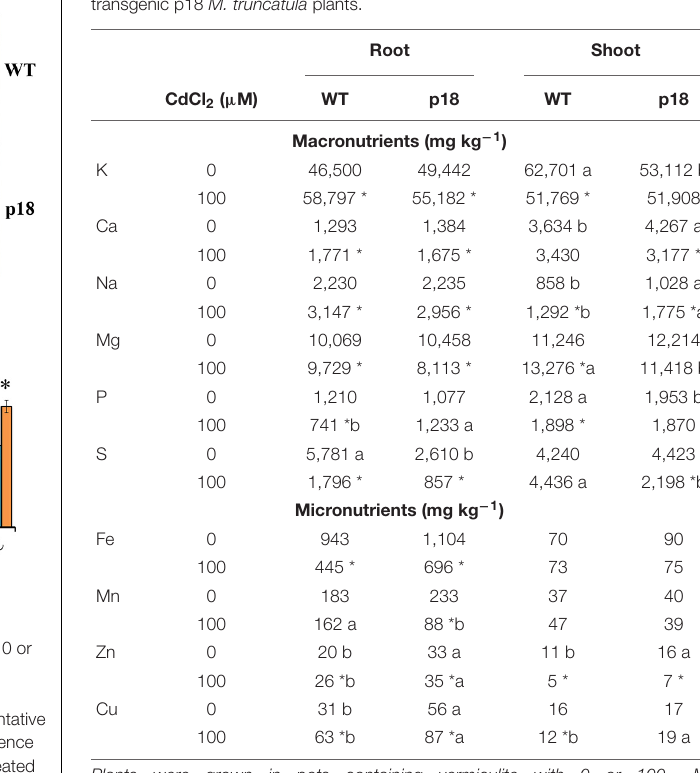
TABLE 2 | Macro and micronutrients contents in roots and shoots of WT and transgenic p18 M. truncatula